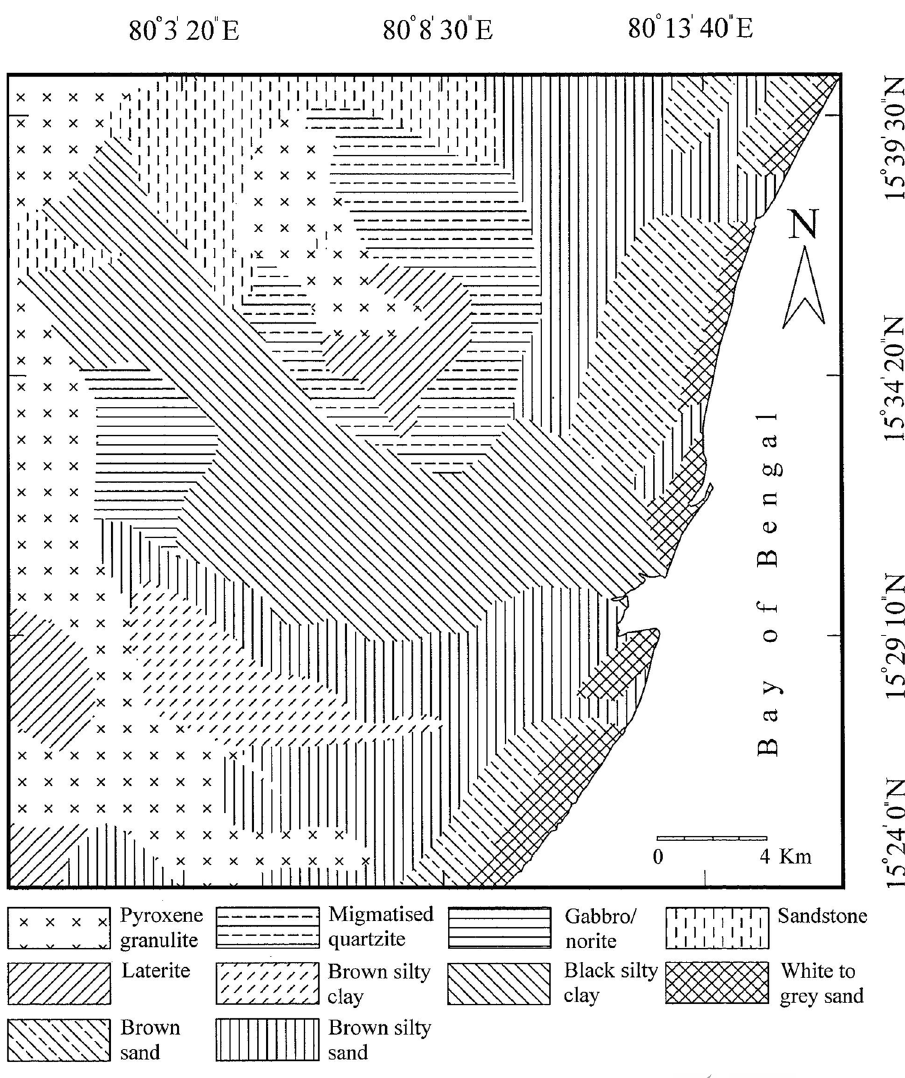
Fig. 2 Geology of the study